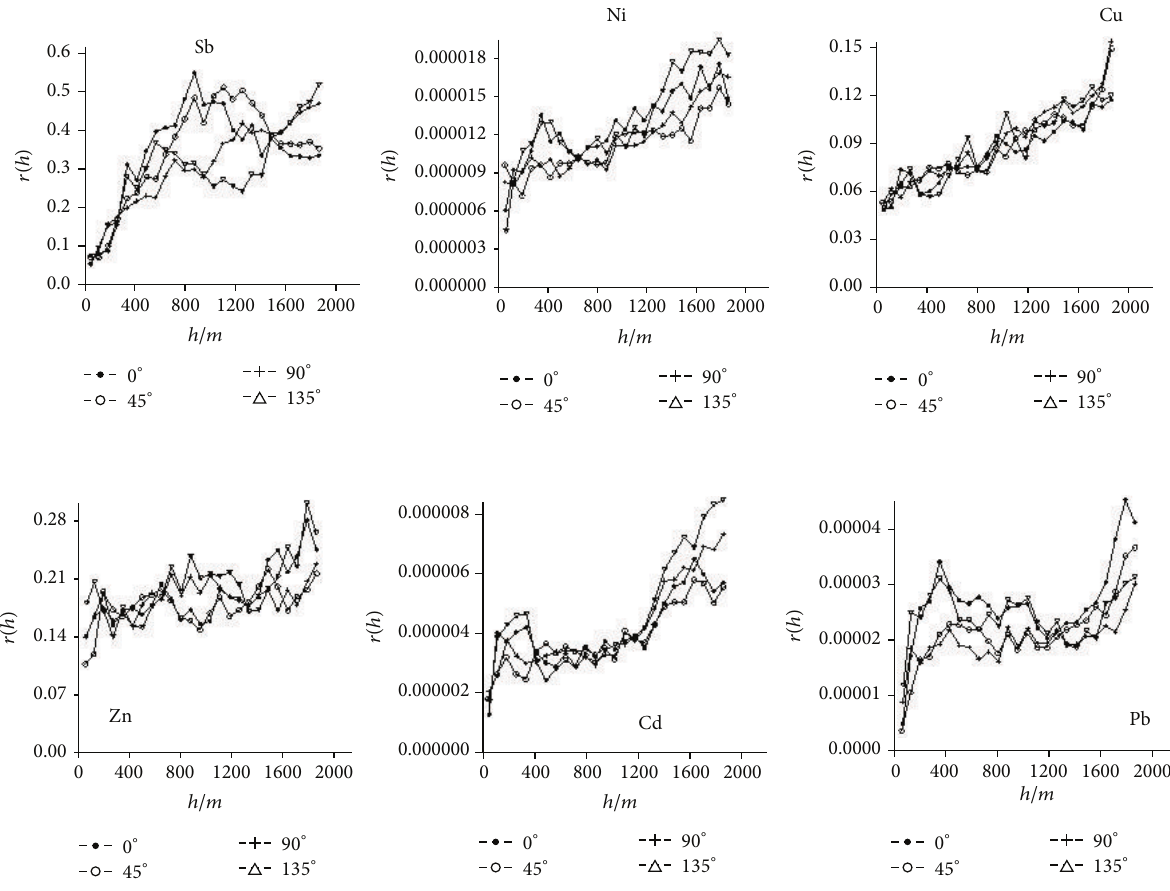
Figure 5: The direction of Sb, Ni, Cu, Zn, Cd, and Pb mutation function in surface runoff in the antimony